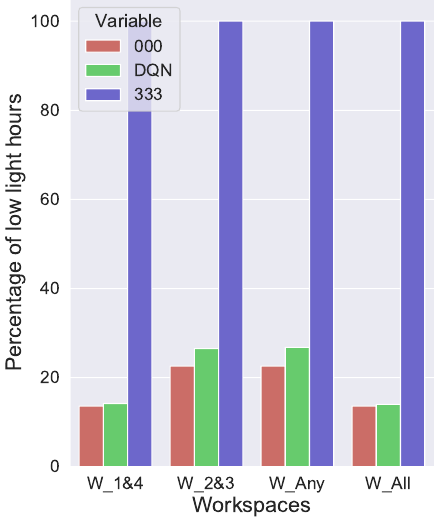
Figure 10. Low light hours at all the workspaces with extreme combinations of EC glass.